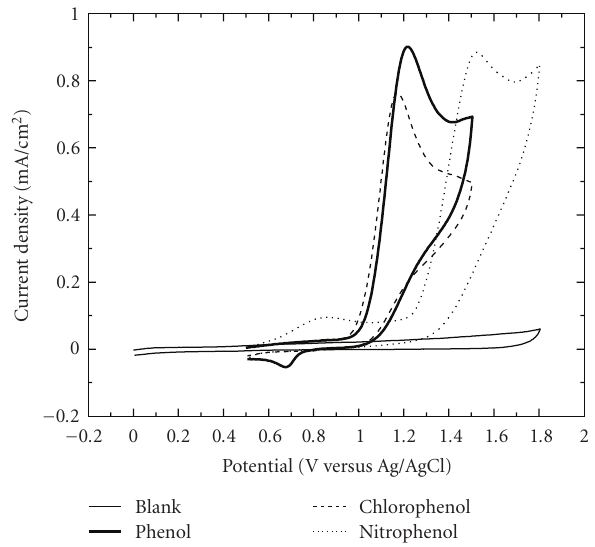
Figure 12: CV i - E curve of 1mmol L − 1 of 4-chlorophenol, 4- nitrophenol and phenol in 0.5mol L − 1 H 2 SO 4 for BDND electrode ( ν = 0.1Vs − 1 ).